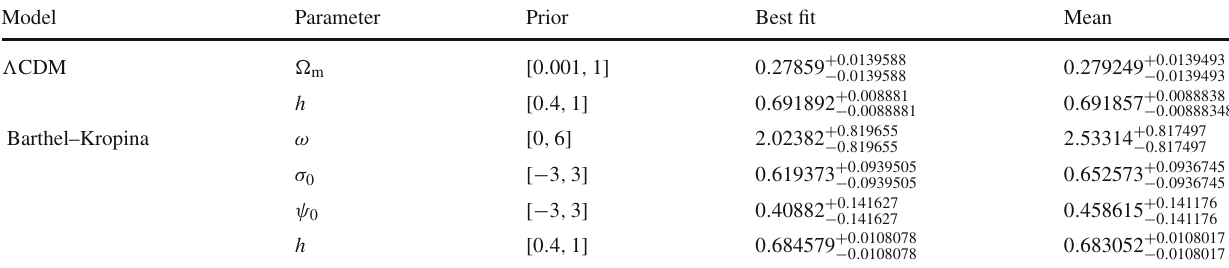
Table 2 Summary of the best fit and of the mean values of the free cosmological parameters of the Barthel–Kropina dark energy model Model Parameter Prior Best fit